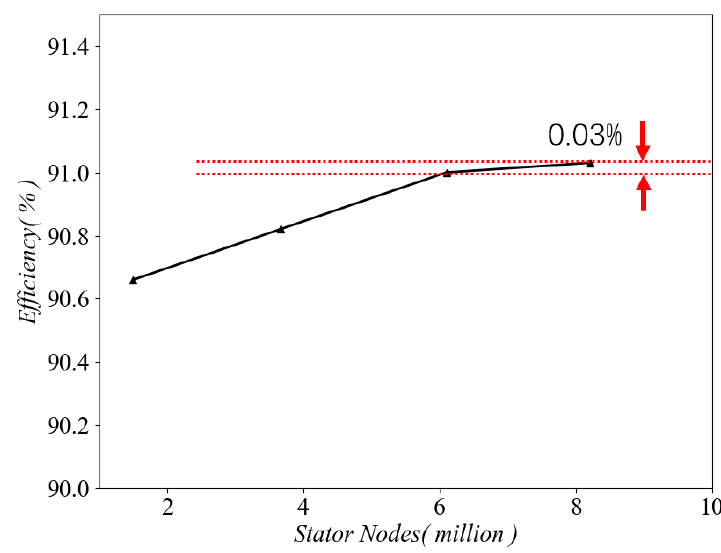
Figure 3. Mesh independence with stator nodes numbers.